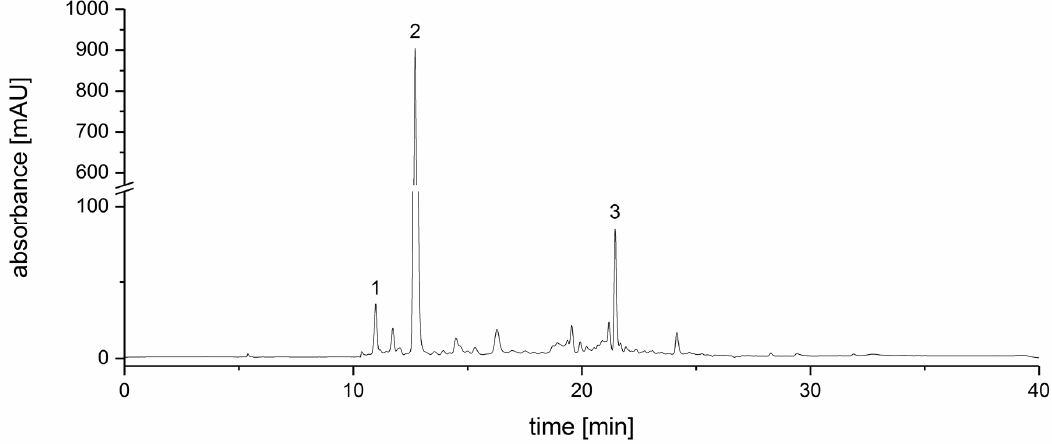
Figure 1. HPLC–UV chromatogram ( λ = 280 nm) of the strawberry tree fruit extract (SFE) ( Arbutus unedo ). The three peaks represent arbutin (1), galloyl quinic acid (2) and the internal standard caffeine (3).